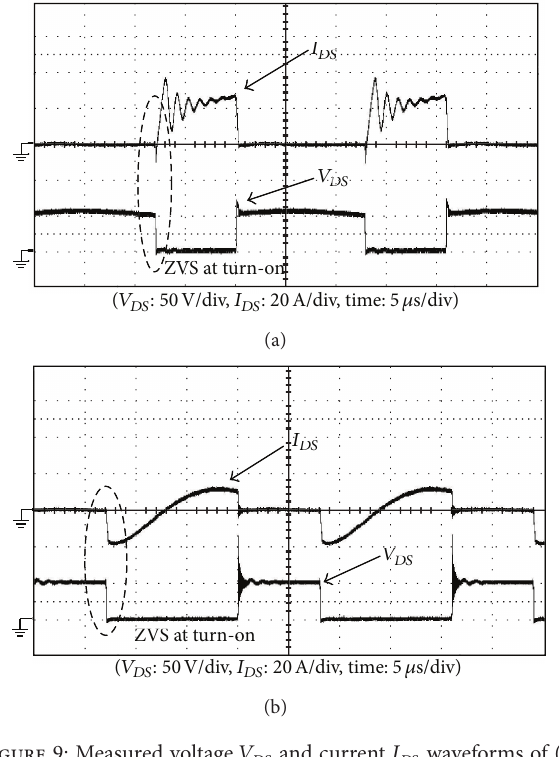
Figure 9: Measured voltage 𝑉 𝐷𝑆 and current 𝐼 𝐷𝑆 waveforms of (a) switch 𝑀 1𝐵 and (b) switch 𝑀 3𝐵 of the proposed converter 50% of fullloadwhentheproposedPVpowerconversionsystemwithboost type snubber.